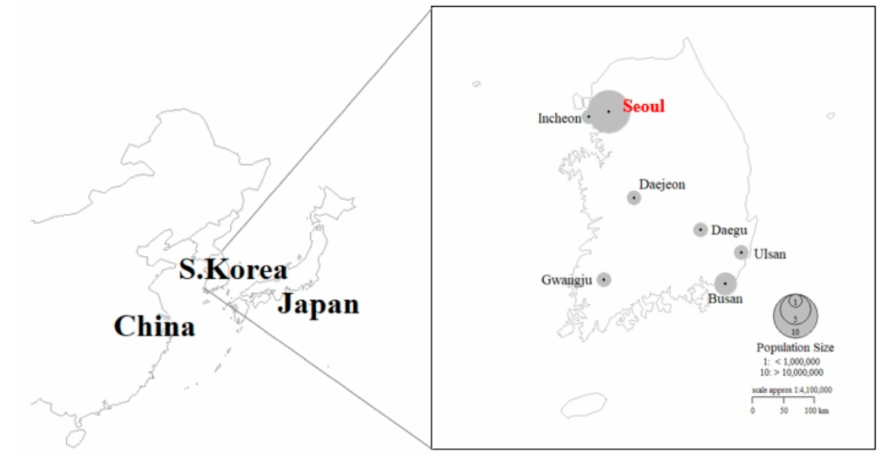
Figure 1. Study location, Seoul, South